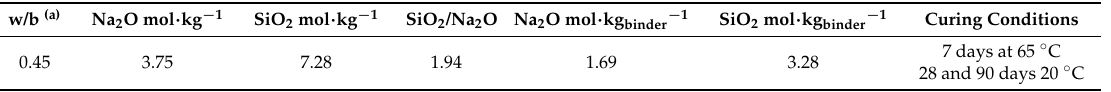
Table 2. The mix proportions, ratios and curing conditions used to assess the influence of BFS and FA on the alkali-activated CSW blended